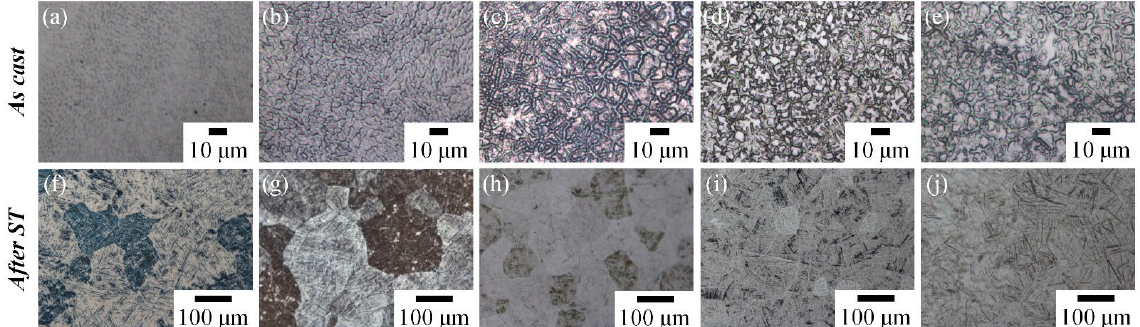
Figure 4. Metallographic images of the Ti–Zr–Nb–Ta MEAs in as-cast and ST states. ( a , f ) Ti 65 –Zr 33 –